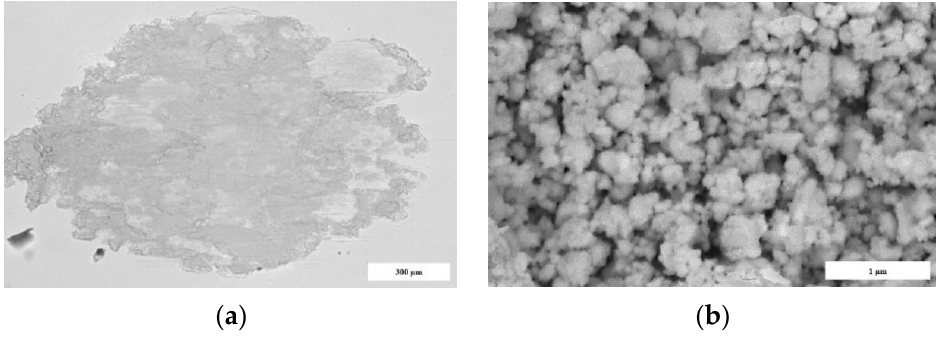
Figure 3. Scanning electron microscopic images (BSE) of a degraded contact zone after a fretting corrosion test: ( a ) Overview of the contact zone (acceleration voltage 20 kV); ( b ) Detailed image of the formed wear particles within the contact zone (acceleration voltage 5 kV).